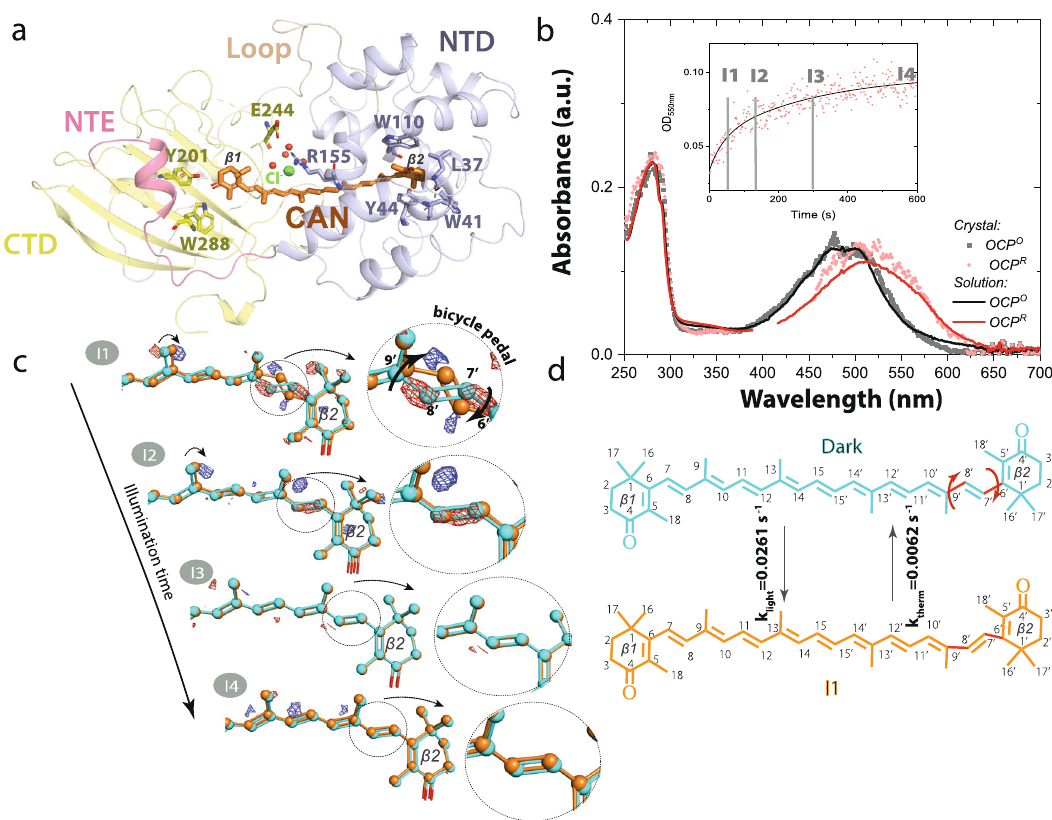
Fig. 1 | Canthaxanthin single bond isomerization in the bicycle-pedal manner triggers OCP light activation. a Structure of OCP in its inactive state (OCP O ) displaying the C-terminal domain (CTD, yellow colour), N-terminal domain (NTD, violent colour), N-terminal extension (NTE, pink colour), and loop (wheat colour). The canthaxanthin (CAN) carotenoid is embedded between the two domains. Cl − (ingreen)isresolvedintheCTDwhereitcoordinatesfourwatermolecules(inred) throughion-dipoleinteractionsatdistancesof3.0 – 4.0Å. b Absorbancechangesof OCP in solution (solid lines) and crystalline state (dotted lines) upon illumination with violet light (at 410nm with 3.5 mWcm − 2 power; FWHM 20nm of the emission spectrum). Inactive state OCP O and active state OCP R are shown in black/grey and red/pink respectively. The OD intensities are unavoidably polluted by the LED emission in 380 – 430nm and therefore were omitted from the graph. Insert: Absorbance changes (pink dots) in the crystalline state detected at 550nm upon 10min of illumination. Black line represents double exponential fi t of the